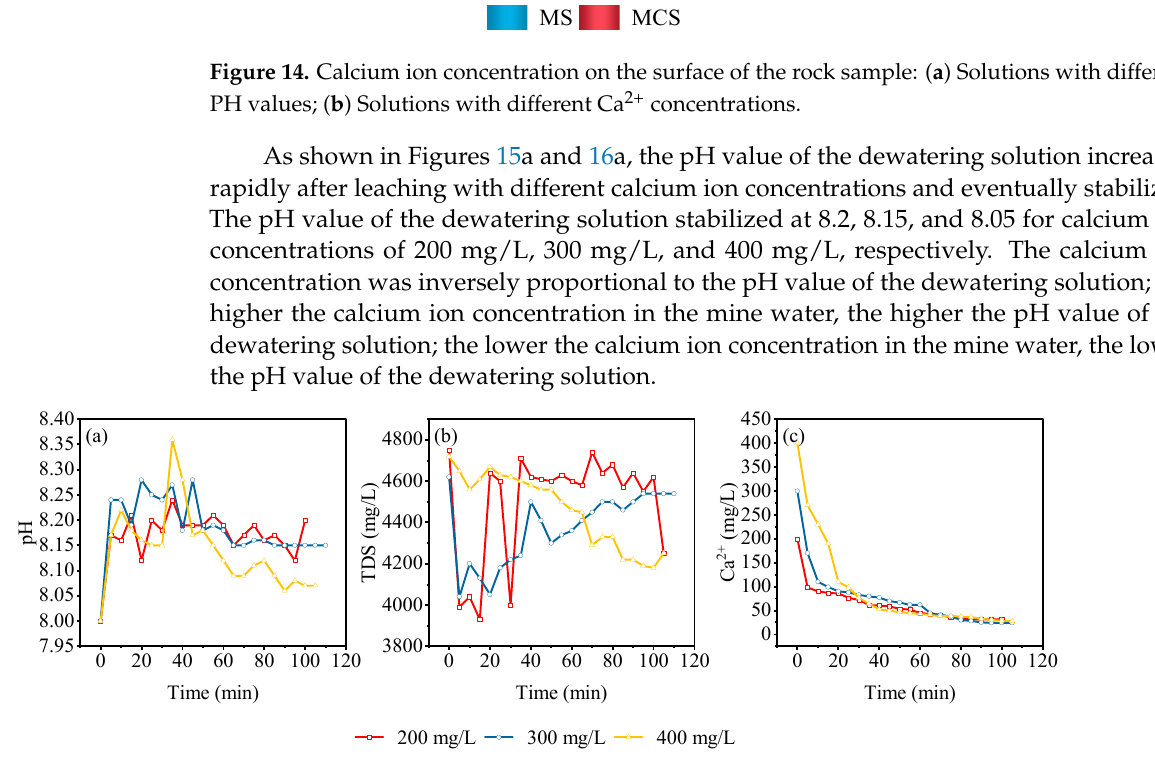
Figure 15. Solution characteristics of muddy siltstone leached by mine water with different concentrations of calcium ions: ( a ) pH value; ( b ) TDS concentration; ( c ) Ca 2+ concentration.